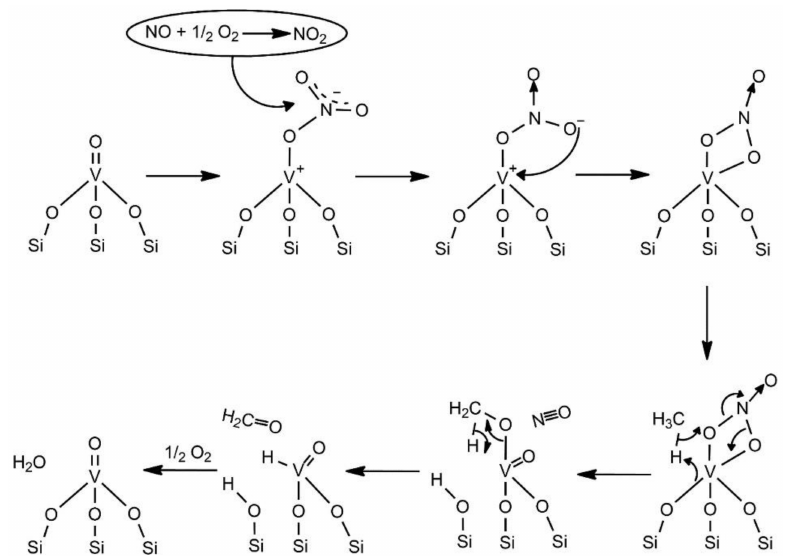
Figure 6. Possible scheme for the formation of HCHO during the CH 4 partial oxidation by NO + O 2 involving the terminal V=O bond and the Si-O-V bond [109]. Copyright 2021, with permission from